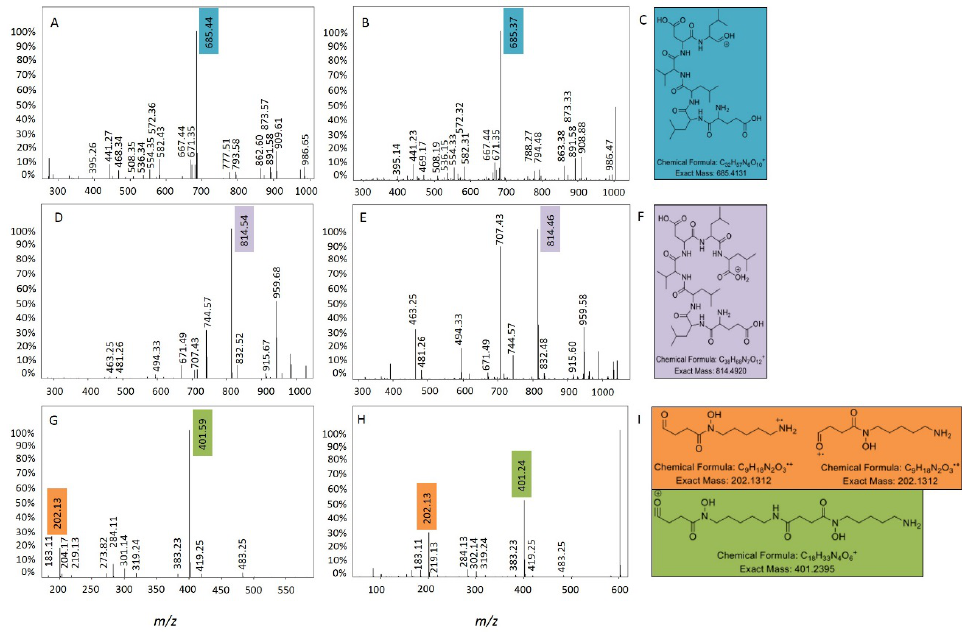
Figure 3. Surfactin C14 ( A ) MS/MS parent ion fragmentation for this study ( B ) MS/MS parent ion